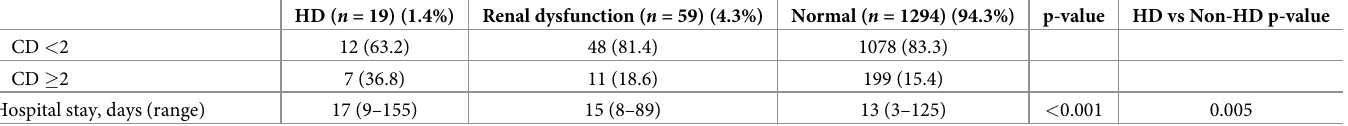
Table 1, except for HD and renal dysfunction. Postoperative complications were defined as those occurring within 30 days of the primary surgery. Anastomotic leak was defined as stool-like changes in abdominal drainage or abscess for- mation around the anastomotic site, confirmed by imaging examination. Pneumonia was defined as the presence of respiratory symptoms and imaging findings of pneumonia. Surgical site infection (SSI) was defined as that in an incision, organ, or abdominal cavity affected by surgery. Urinary tract infection was defined as pyuria according to urinalysis. Among the post- operative complications in the HD group, urinary tract infection was defined as patients with urine output who had findings of urinary tract infection. Pseudomembranous colitis and MRSA colitis in which the cause could be identified was termed colitis. Paralytic ileus was defined as the presence of abdominal distension or vomiting, with imaging findings of a dilated intestinal tract suggestive of ileus. Anastomotic bleeding was defined as the presence of melena after surgery and that was confirmed by colonoscopy. Delirium was defined as a tran- sient psychiatric symptom that developed postoperatively. Thrombosis was defined as symp- toms of lower limb pain and dyspnea, elevated D-dimer in blood tests, with thrombus identified by ultrasonography or contrast CT, including deep vein thrombosis and pulmonary embolism. Lymphorrhea was defined as milky white ascites with high triglyceride levels and without infectious from abdominal drainage. “Other” included postoperative cholecystitis, neuroleptic malignant syndrome, or stomach volvulus. CD > 2 complications were defined as those requiring antibiotic treatment, surgery or advanced medical care; and death. This time, we focused on CD grades 2 and higher because these are clinically problematic. Statistical analysis was performed using Bell Curve for Excel software, version 3.00. The data are presented as median values with ranges. Differences in categorical variables were com- pared using Fisher’s exact test or the chi-squared test. Differences in continuous variables were analyzed with One-way ANOVA (analysis of variance).